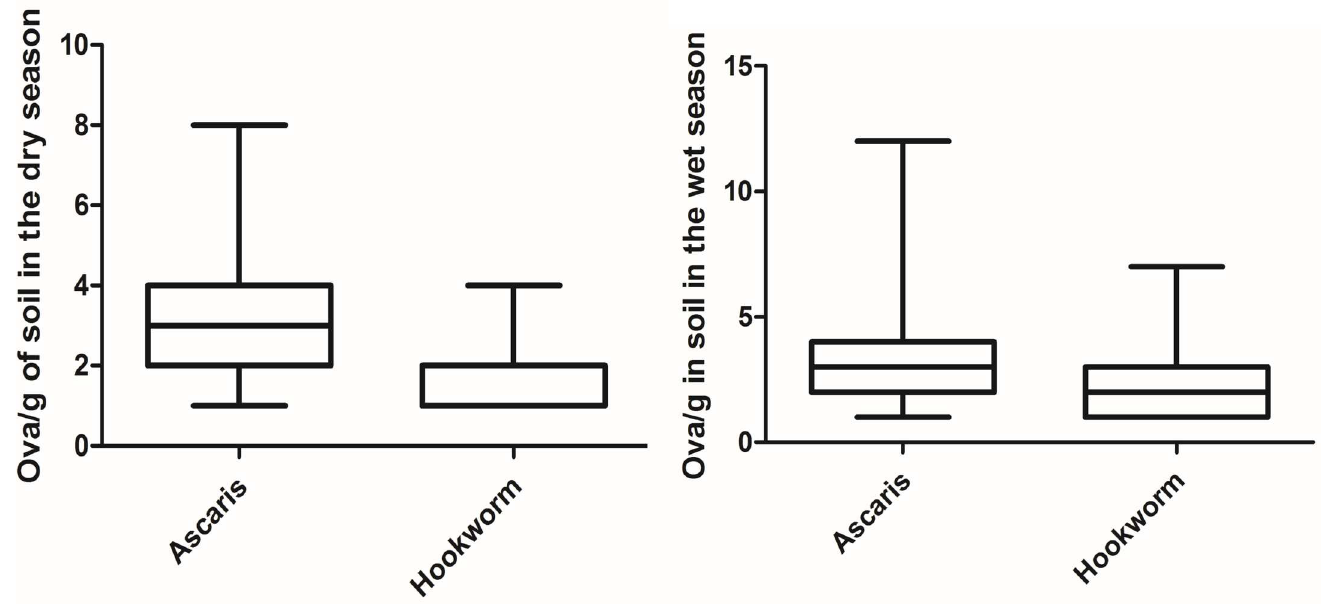
Fig 3. Distribution of Ascaris spp and hookworm ova in farm soil in the dry (n = 71) and wet (n = 107) seasons.